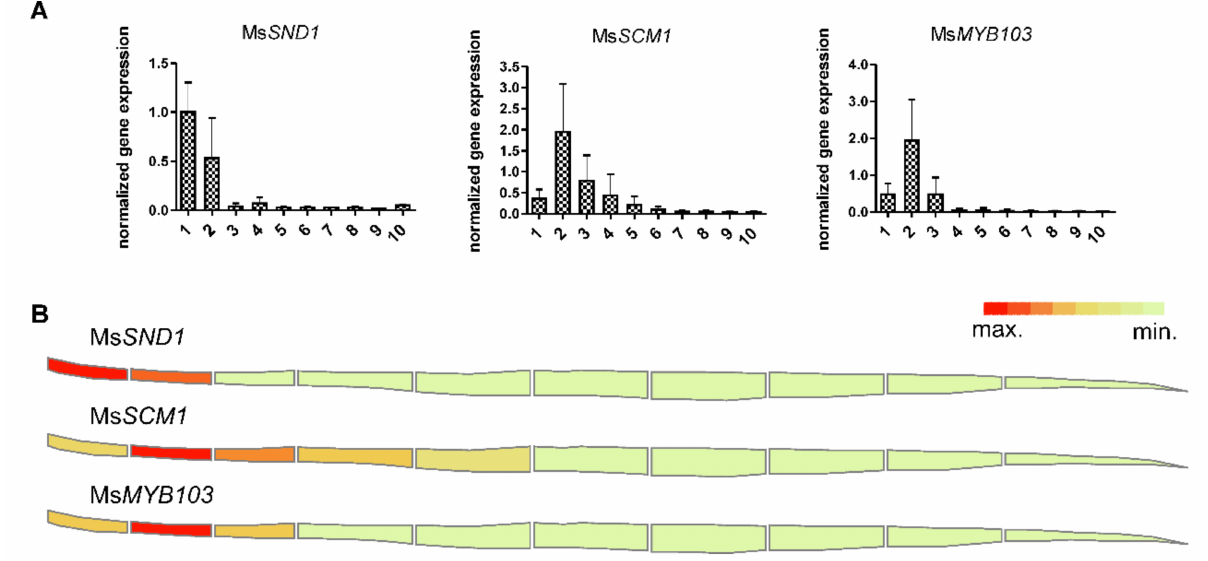
Figure 1. Expression of MsSND1, MsSCM1, and MsMYB103 is associated with tissues undergoing lignification. Developing leaves of ~50 cm length were dissected into ten sections spanning from leaf base at the left side to leaf tip on the right side. Relative gene expression values are calculated from three biological replicates ( A ), which are normalized against two reference genes (UBC and PP2A) and visualized as a heat map ( B